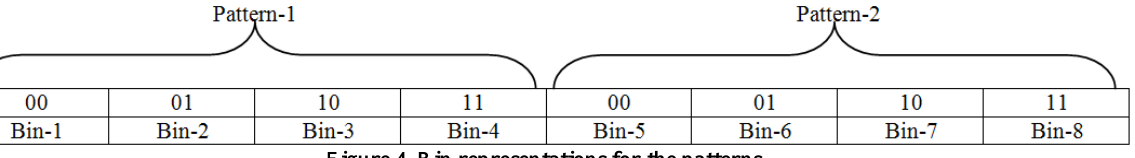
Figure 4. Bin representations for the patterns